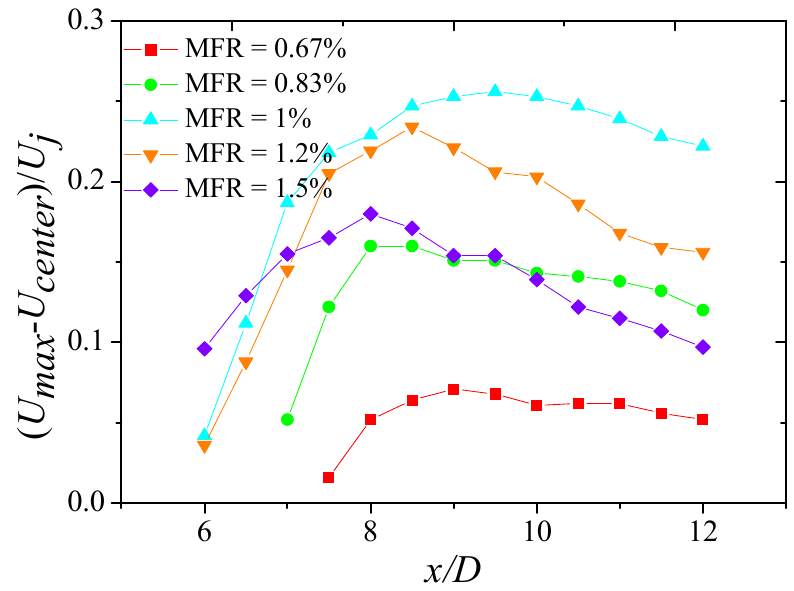
Figure 11. Bifurcation strength for different amplitudes.